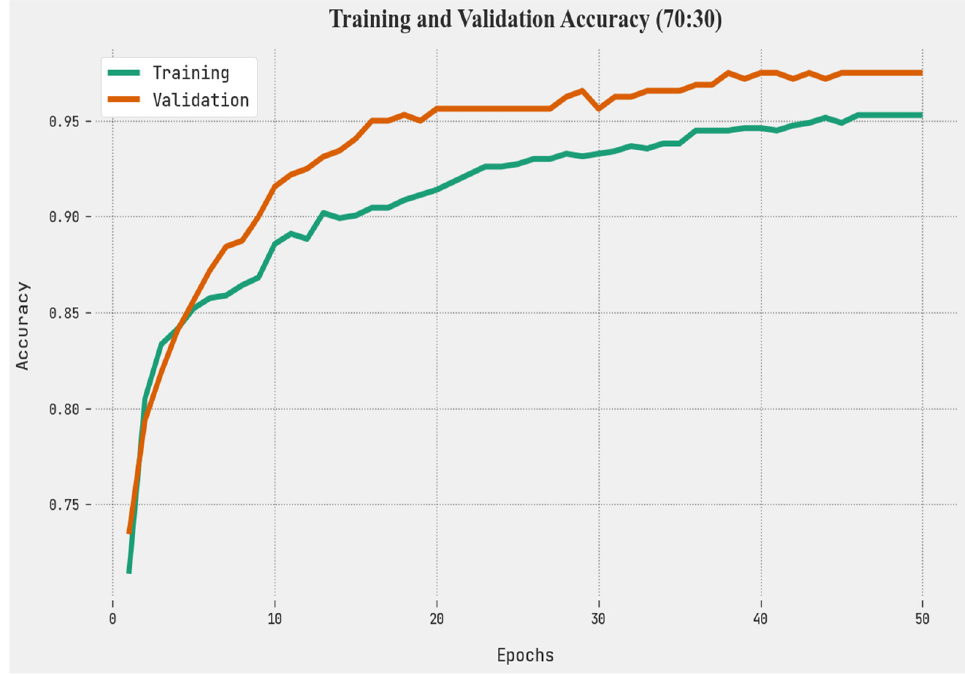
Figure 11. TACC and VACC analysis of TSADL-LULCCD approach on 70:30 of TR/TS database.